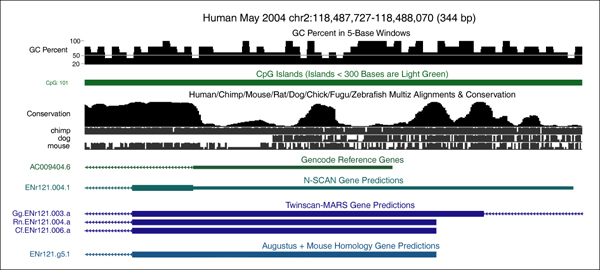
Initial exon of a gene where N-SCAN correctly discriminates coding region from the 5' UTR. Other gene prediction systems predict longer coding regions due to the high G+C content of the region. (Screen shot obtained from UCSC Genome Browser web site [23].)